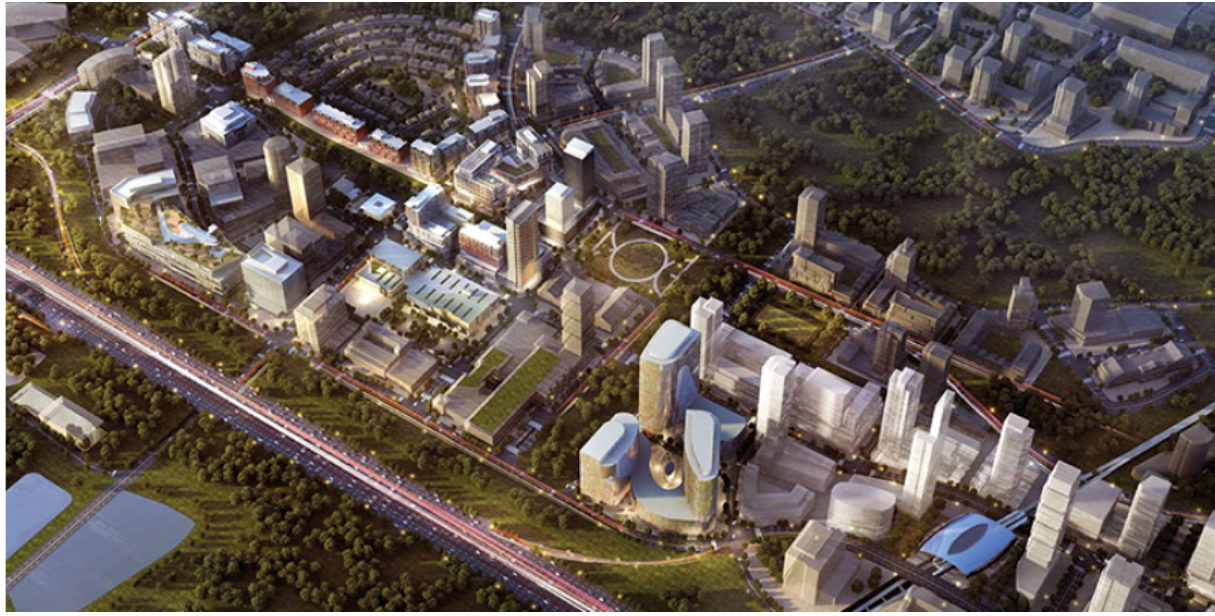
Figure 4. Contemporary Vision for Markham Centre. Source: Remington Group